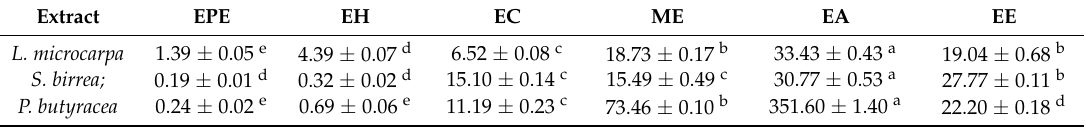
Table 5. Evaluation of polyphenol contents (mg EAG/g) according to extraction solvent. Extract EPE EH